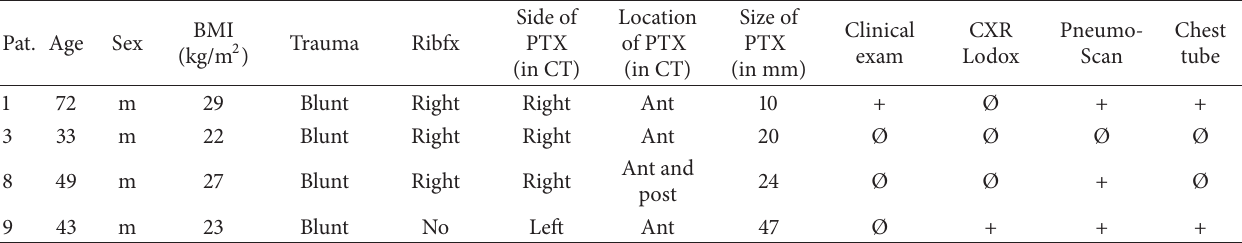
Table 2: Summary of results and patient characteristics with CT scan affirmed PTX.